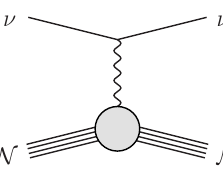
Figure 1. Elastic scattering of a neutrino ν o ff a nucleus N